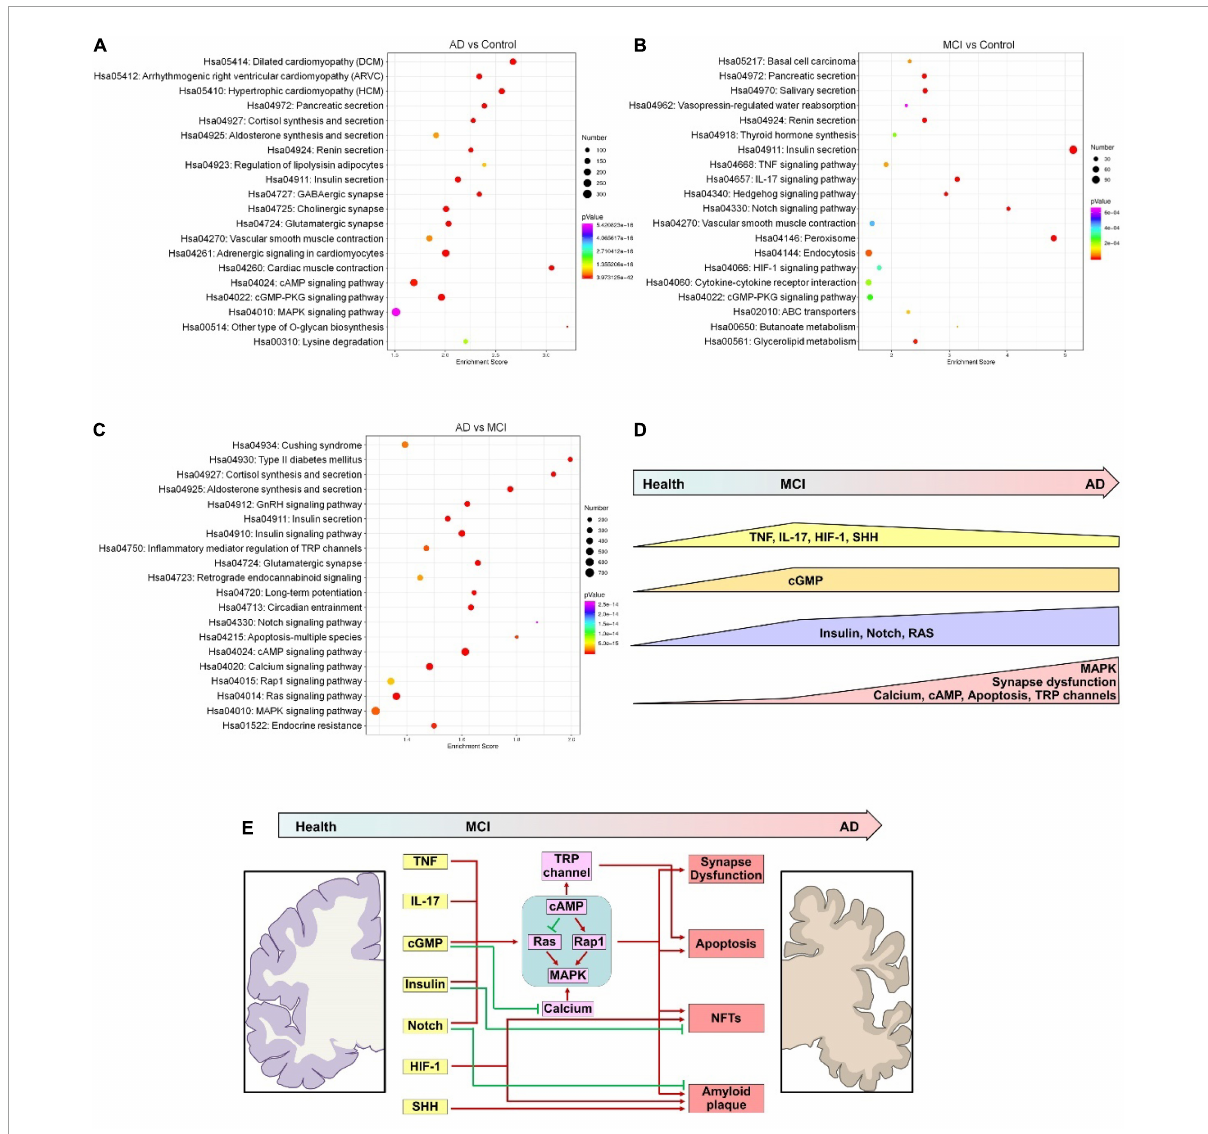
FIGURE4 KEGG analyses of predicted targets of DECEmiRs during AD progression. (A–C) Top 20 significant signaling pathways of the predicted targets of DECEmiRs in AD vs. Control comparison (A) , MCI vs. Control comparison (B) , and AD vs. MCI comparison (C) . (D) The scheme showing the temporal dynamic alterations of signaling pathways regulated by DECEmiRs during AD progression. (E) The scheme showing the signaling pathways temporally regulated by DECEmiRs during AD progression and their participation in biological